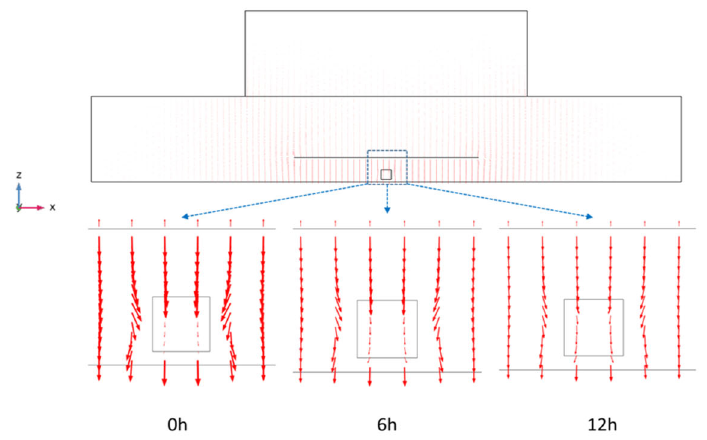
Figure 3. Electric field distribution in the central section of the radio frequency heater cavity ( y = 300 mm).